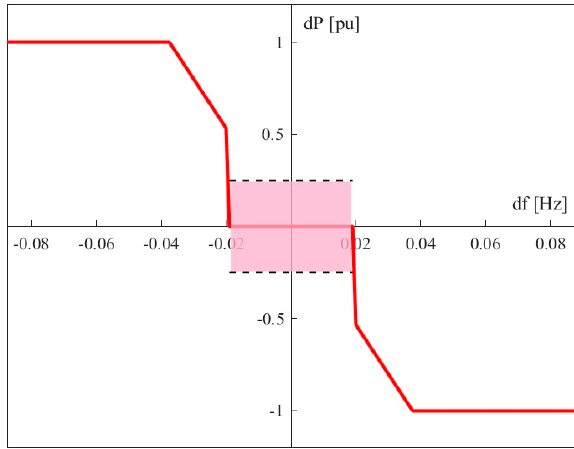
Figure 6. Droop curve for dead-band strategy, with the pink area showing the range of possible offsetting guaranteed by the DoF.